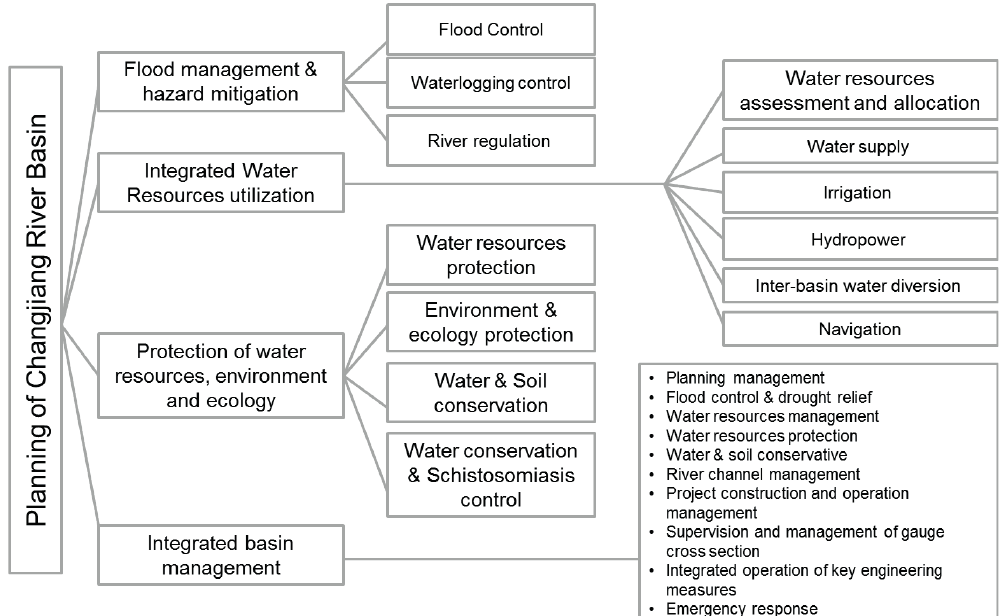
Fig. 2 Framework of river basin planning of Changjiang River